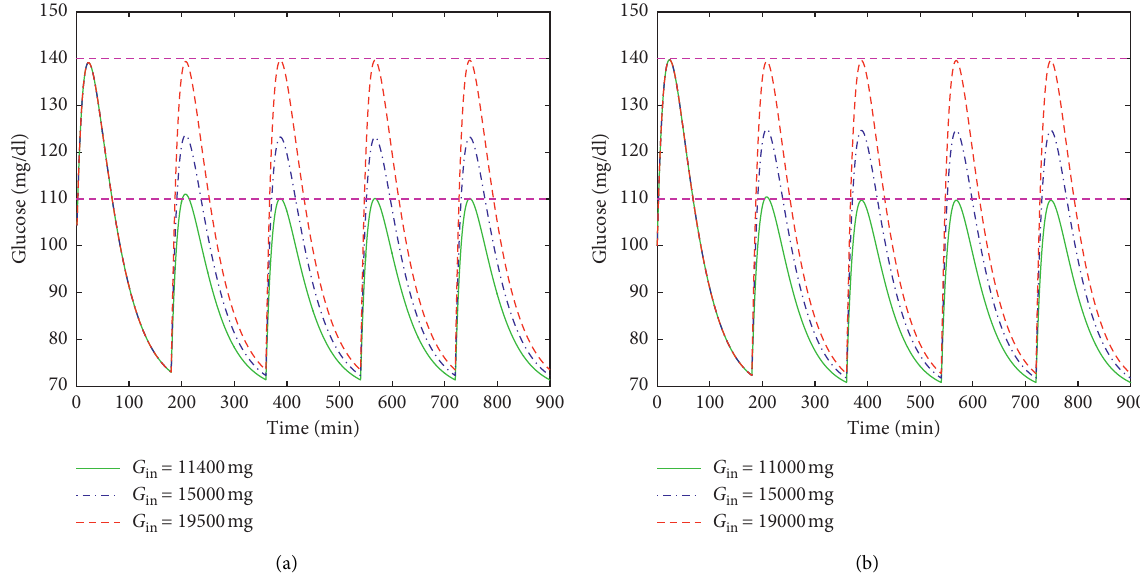
Figure 6: Range of glucose intake amount for maintaining normal glucose level when τ � 180min: (a) range of glucose intake amount of system (5) and (b) range of glucose intake amount of system (8).